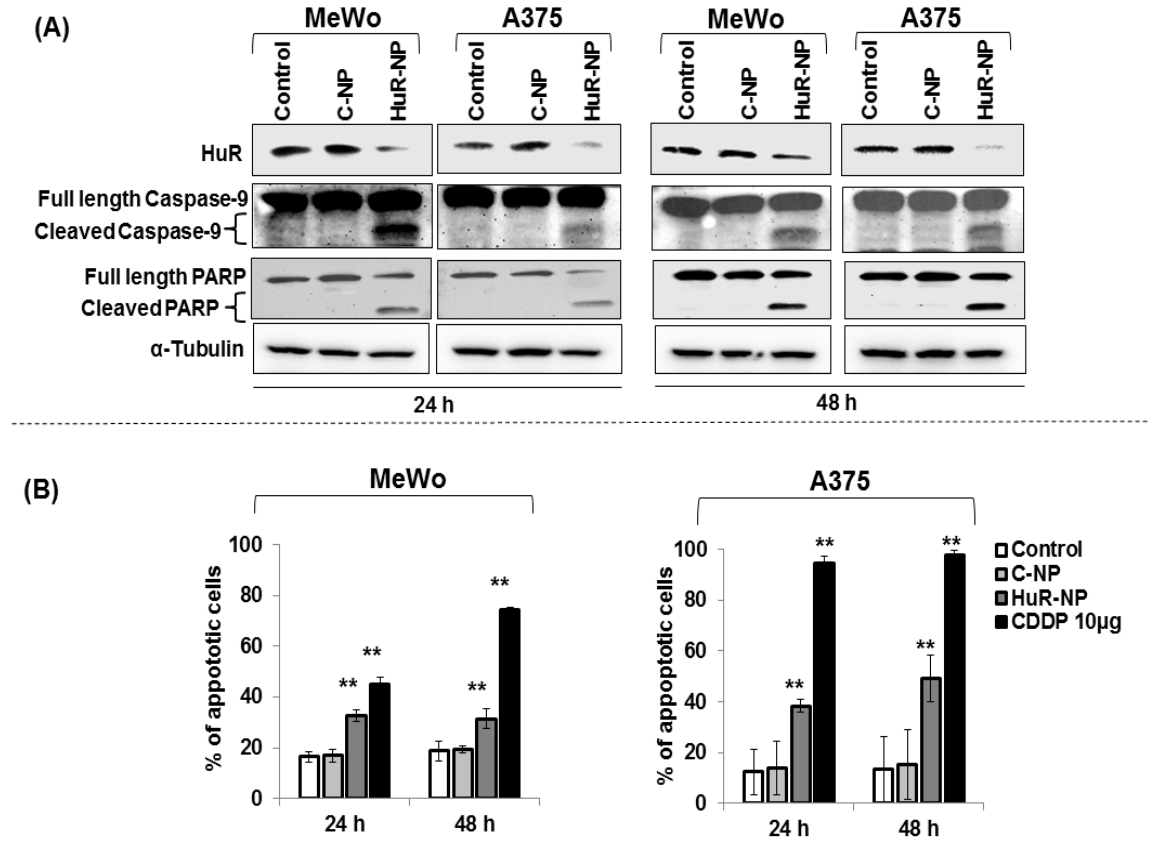
Figure 4. HuR-NP induced apoptosis in melanoma cell lines . Assessment of apoptosis in melanoma cell lines (MeWo, A375) at 24 h and 48 h after treatment with either C-NP or HuR-NP. Untreated cells served as control. ( A ), Western blotting showed caspase 9, and PARP cleavage was greater in HuR-NP-treated cells than in controls. ( B ), Annexin V staining was determined by flow cytometry. Cells treated with cisplatin (CDDP) served as a positive control for each cell line. Error bar denotes SD; ** p < 0.01.